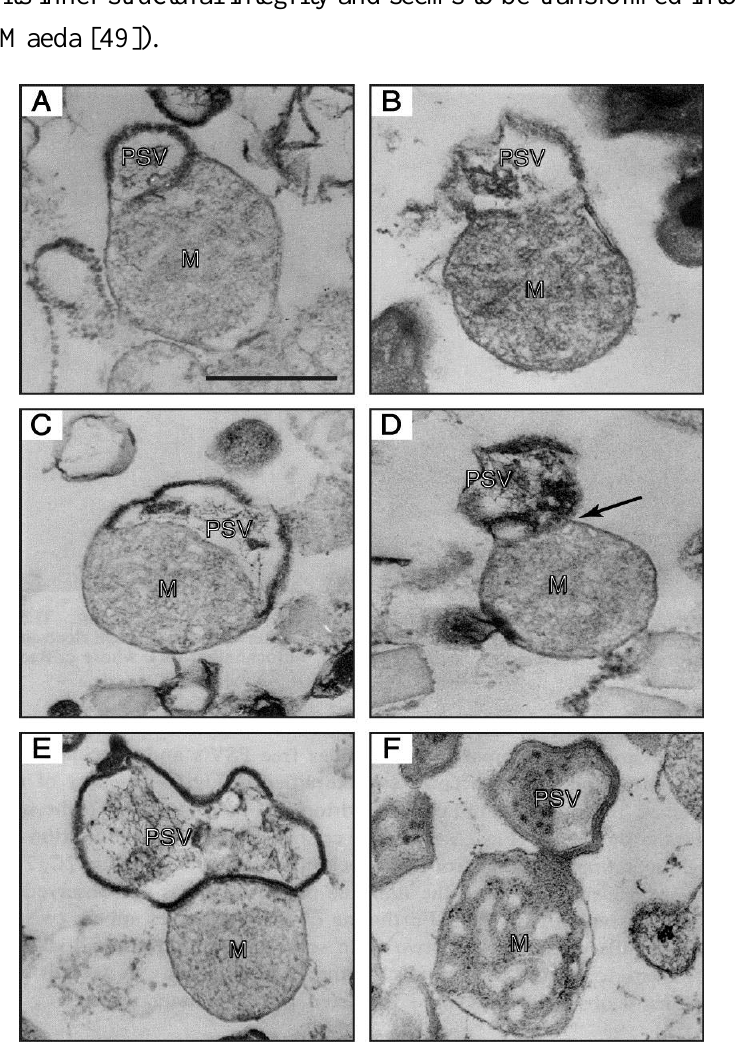
Figure 6. Electron-micrographs of PSV-mitochondrion complexes present in a 47.5%–50% fraction (the intermediate fraction between a lighter pure mitochondria and a heavier pure PSV fractions) of a multilayered sucrose gradient for cell fractionation. ( A , B ) the outer membrane of a mitochondrion (M) is continuous with the unit membrane of a